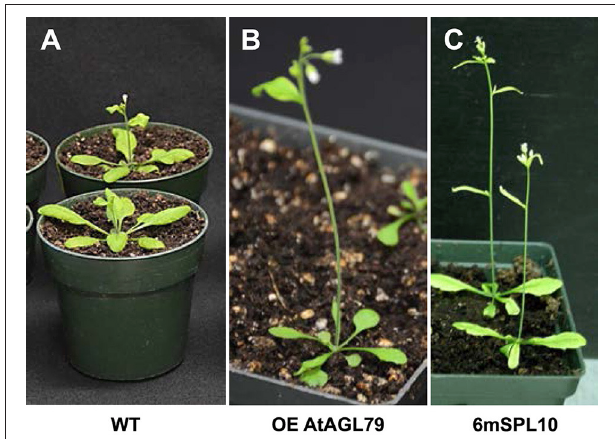
FIGURE 4 | Phenotypic characterization of AGL79 misexpression Arabidopsis plants. All the used plants were grown at the same time and conditions, and the comparisons were carried out when WT reached the bolting stager. (A) WT plants. (B) Arabidopsis plants with highest AGL79 gene over expression (OE).